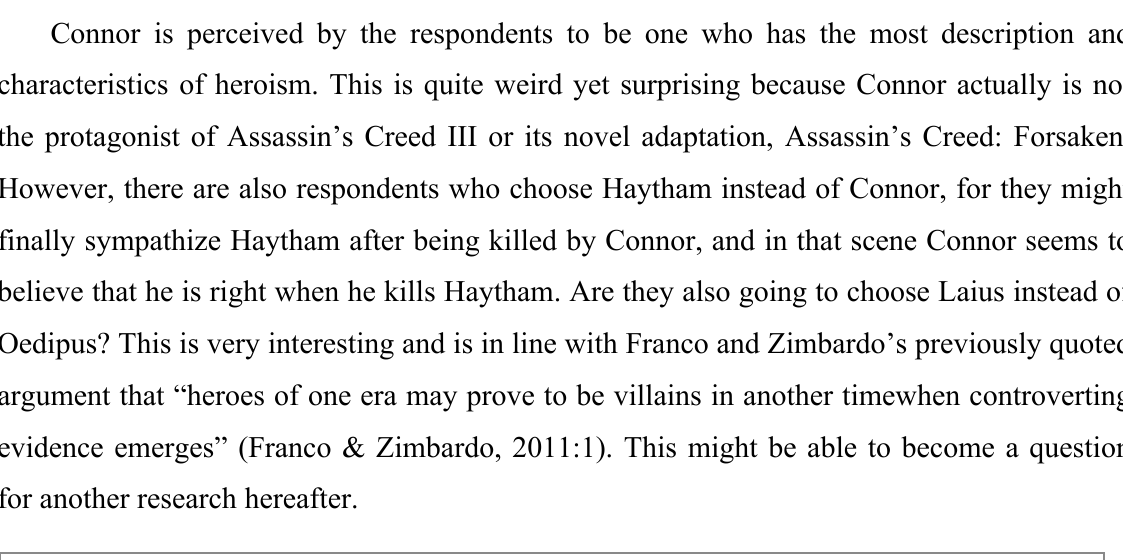
Figure 2: Most Favorite Character